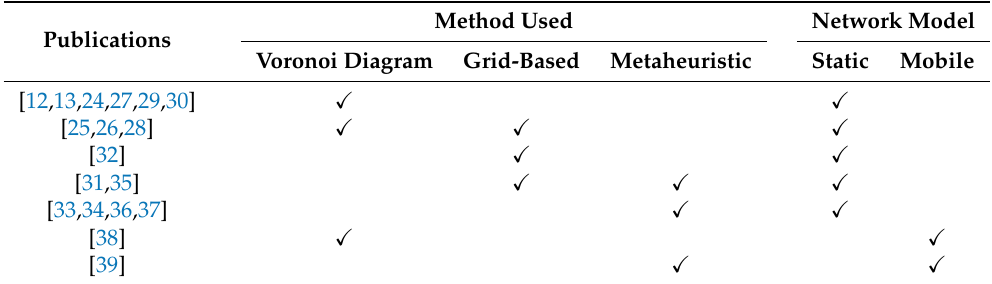
Table 1. Comparative table of related works on the MEP problem.